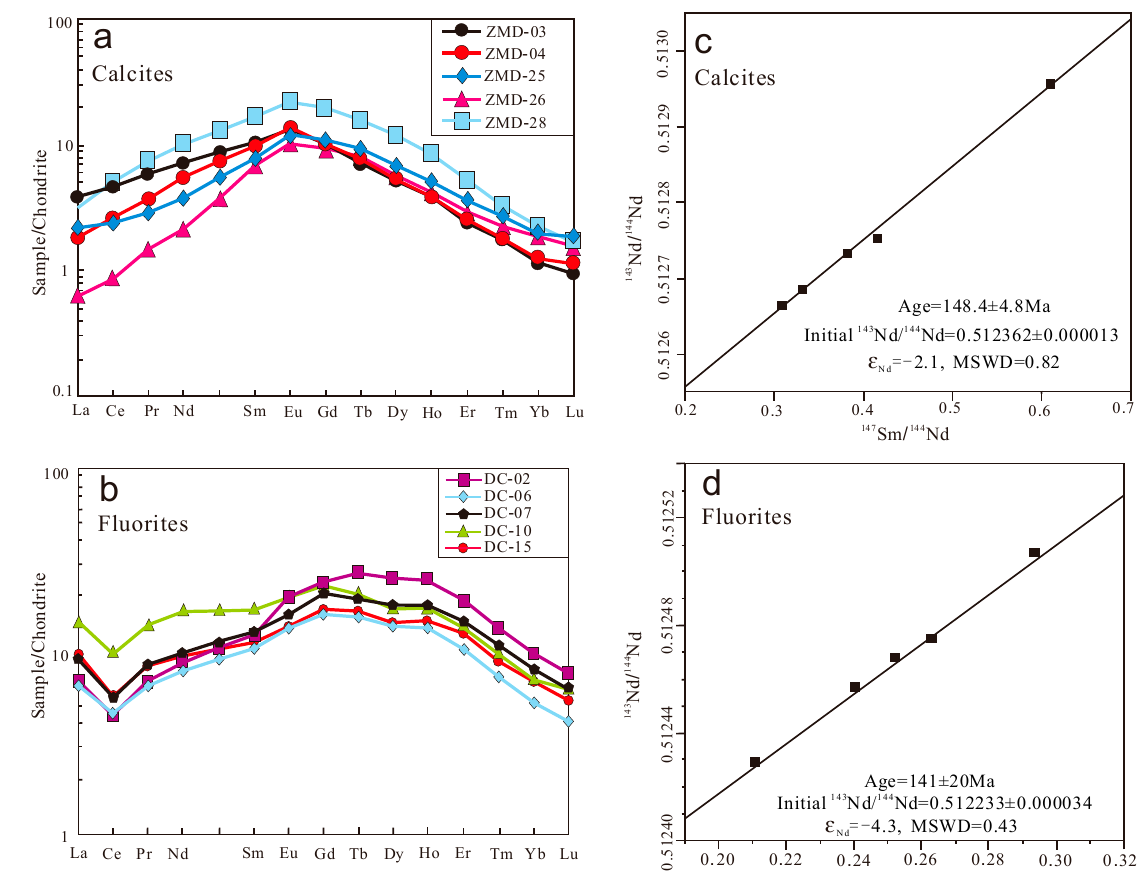
Figure 5. C1 chondrite-normalized [43] rare earth element (REE) patterns ( a , b ) and corresponding Sm–Nd isochron ages ( c , d ) of the calcite and fluorite.